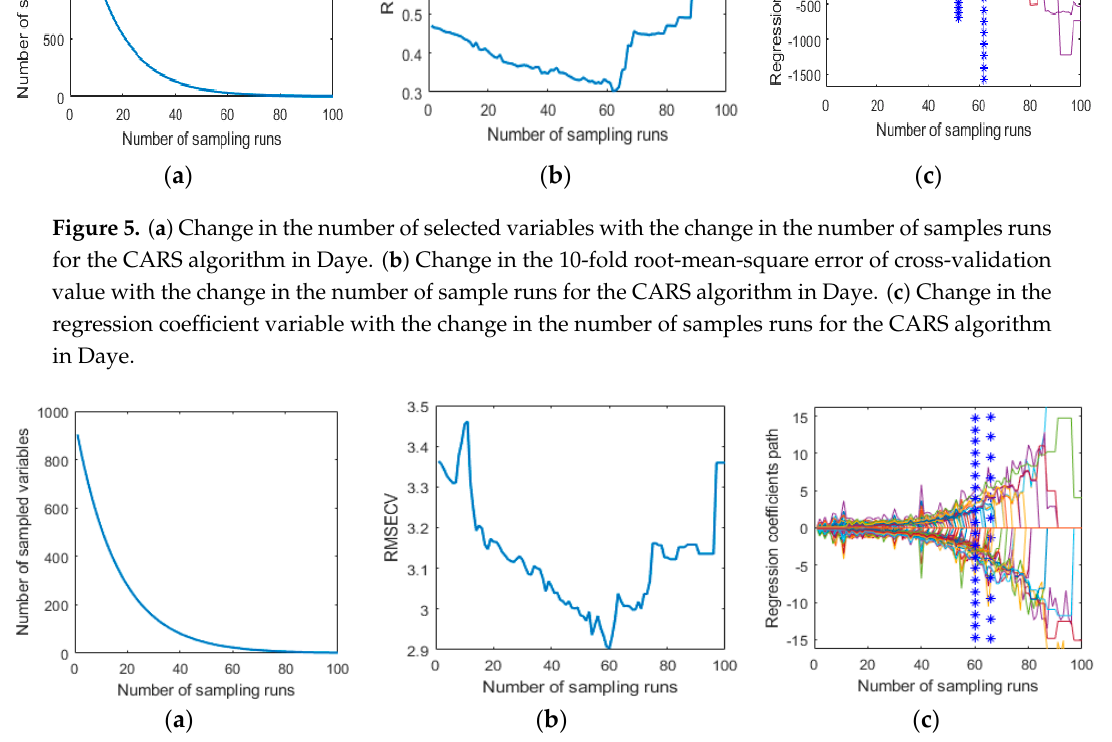
Figure 6. ( a ) Change in the number of selected variables with the change in the number of samples runs for the CARS algorithm in Honghu. ( b ) Change in the 10-fold root-mean-square error of cross-validation value with the change in the number of sample runs for the CARS algorithm in Honghu. ( c ) Change in the regression coefficient variable with the change in the number of samples runs for the CARS algorithm in Honghu.